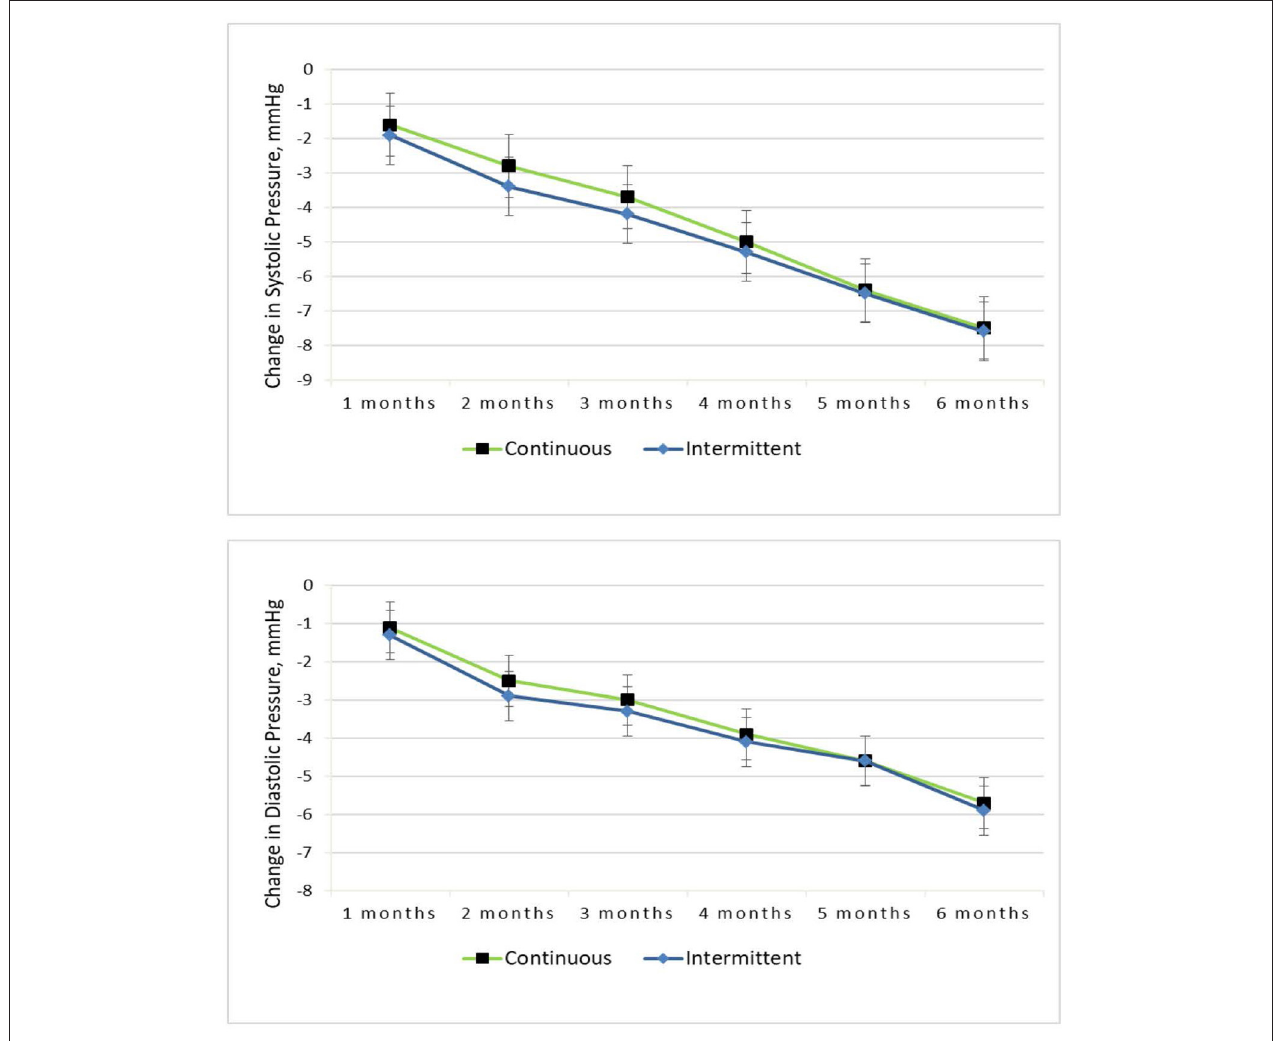
FIGURE 3 | Change in systolic and diastolic pressure from baseline to 6-months for the continuous vs. intermittent groups (completer